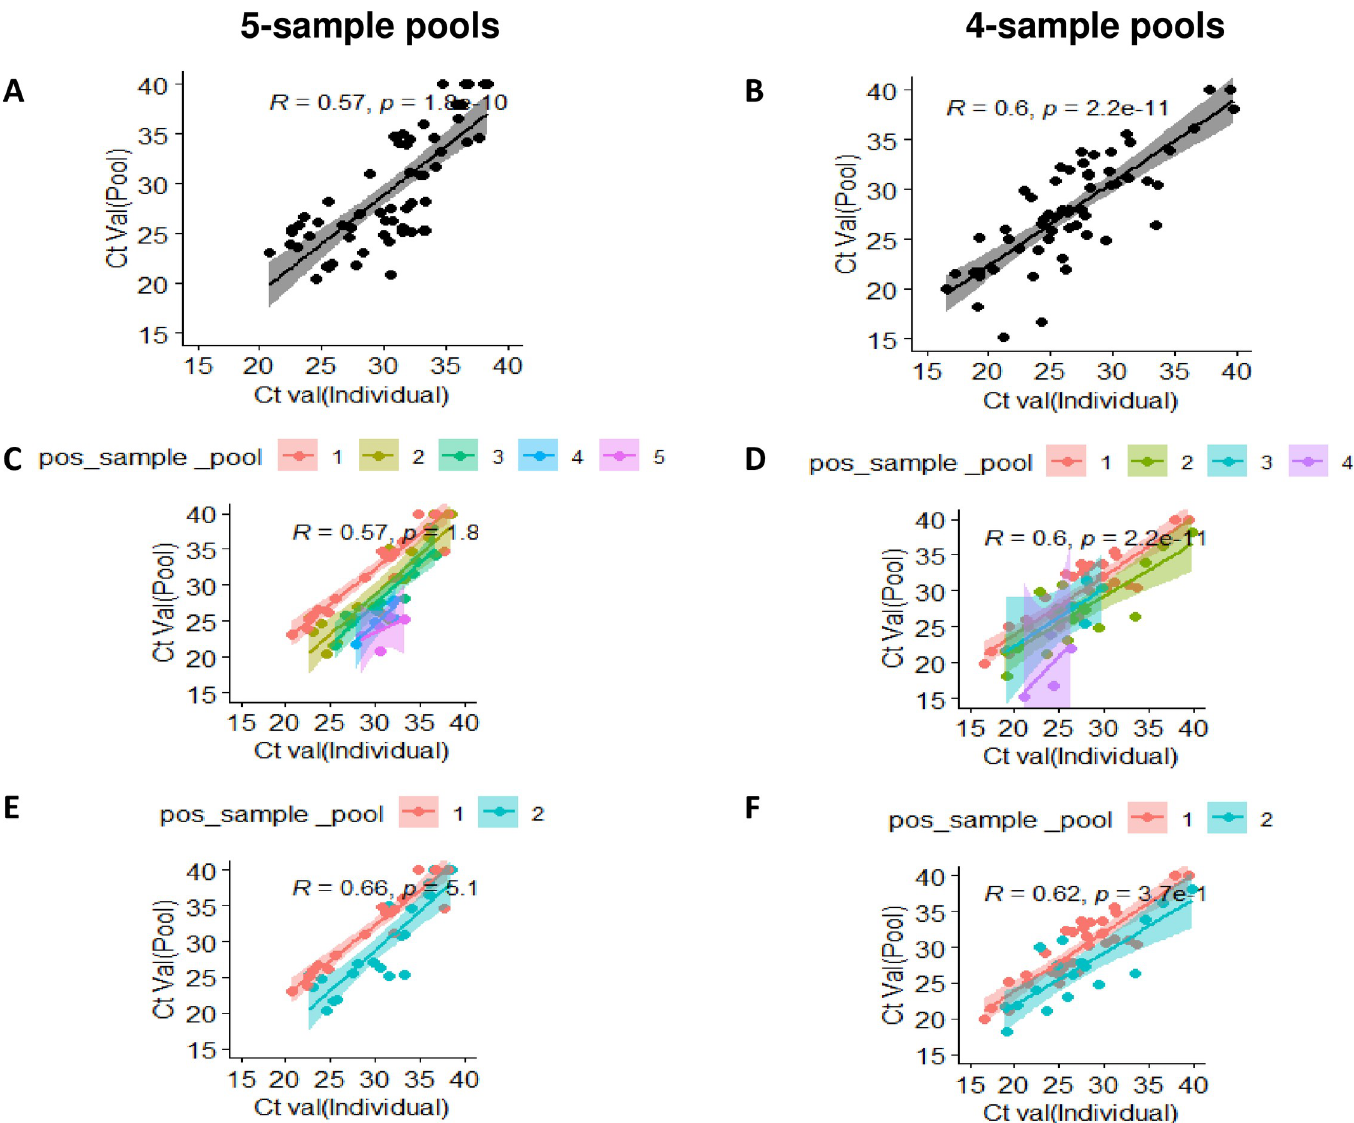
Fig 2. Paired correlation between individual Ct value and corresponding pool Ct value with Kendall tau’s coefficient and slopes. (A-B) 4 and 5-sample pools with all positive samples (C-D) 4 and 5-sample pools with individual slopes for all positive samples in the pool, (E-F) 4 and 5-sample pools with individual slops for 1 and 2 positive samples in the